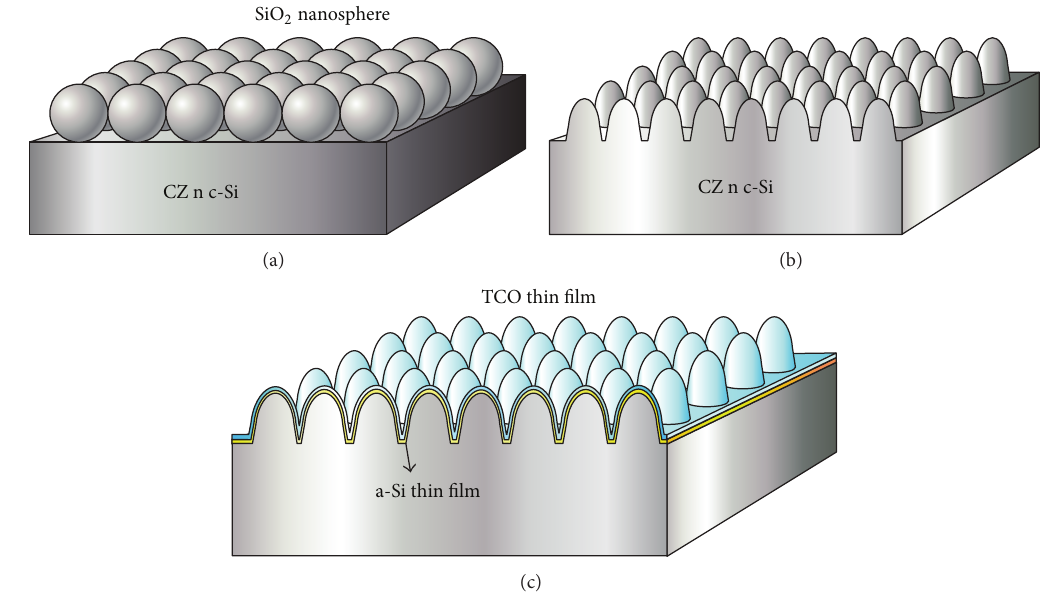
Figure 1: Flow chart of preparation of NPSiS HJT solar cells; (a) coating monolayer of SiO 2 nanospheres on CZ n-type c-Si substrate; (b) using SiO 2 nanospheres as etching mask in ICP process to fabricate NPSiS; (c) depositing the p-type a-Si: H thin films and TCO thin films by RF magnetron sputtering.